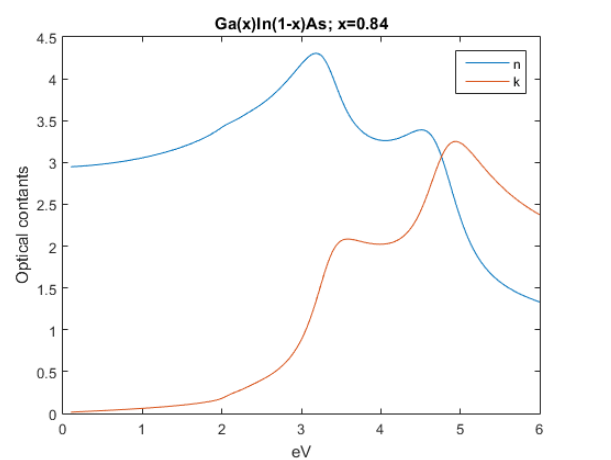
Figure 5. Real and imaginary optical constants of GaAs.